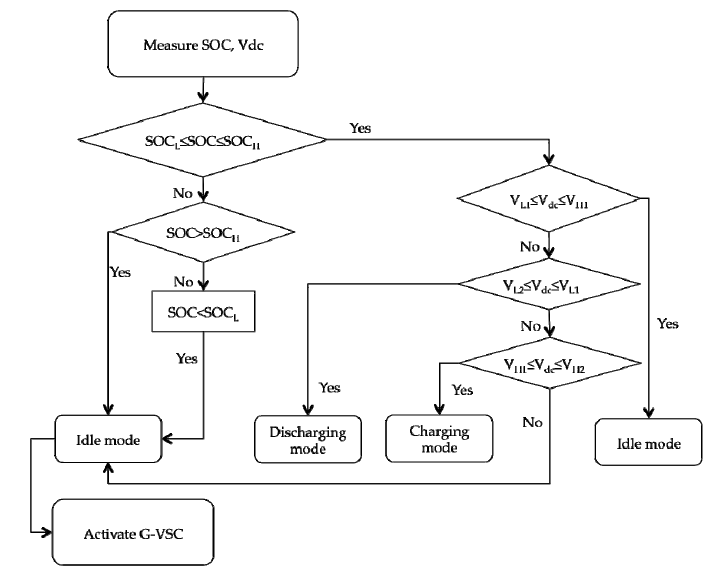
Figure 4. Battery controlled strategies. SOC: state of charge; VSC: voltage source converter.